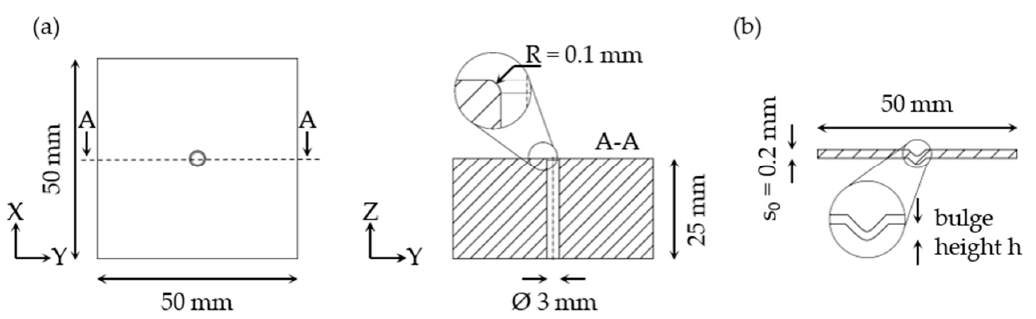
Figure 3. Forming experiment; ( a ) free forming die geometry; ( b ) resulting workpiece geometry.